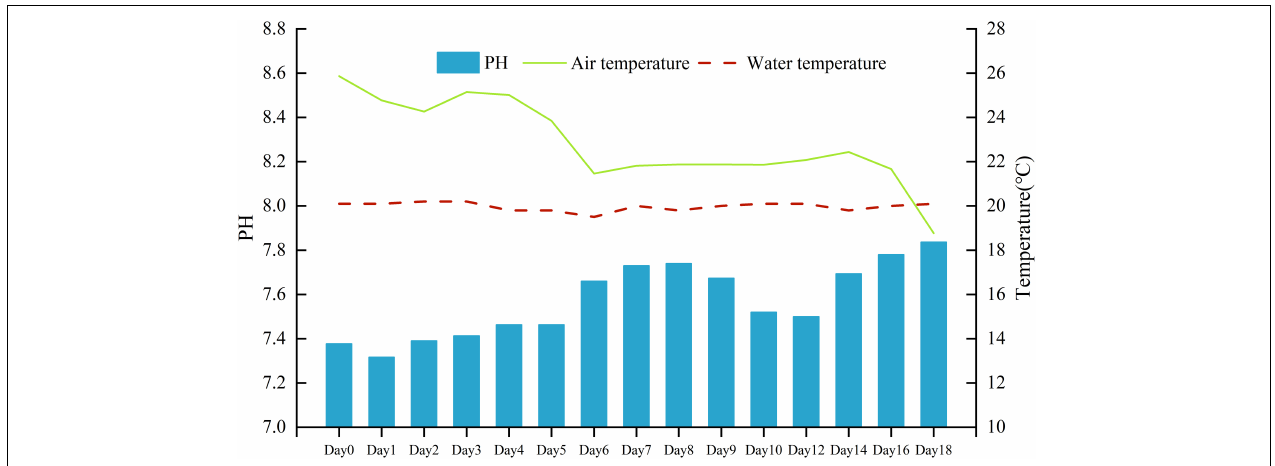
FIGURE 1 | Daily air temperature, water temperature ( ◦ C), and water pH during the experiment.